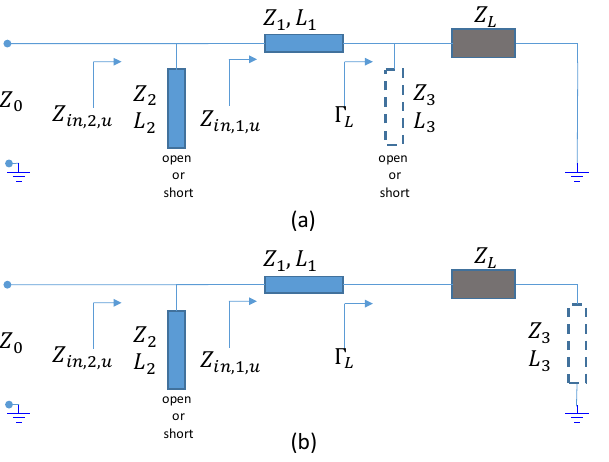
Figure 1. Circuit diagram of the matching network. Z L is the load to be matched at two frequencies f a and f b ; Z 1 ( 2 ) and L 1 ( 2 ) are parameters of transmission lines to be determined to match Z L to Z 0 . Z 3 and L 3 parameters of a possible additional transmission line: it can be placed in front of the load as a stub (open or short) ( a ) or alternatively in series ( b ).